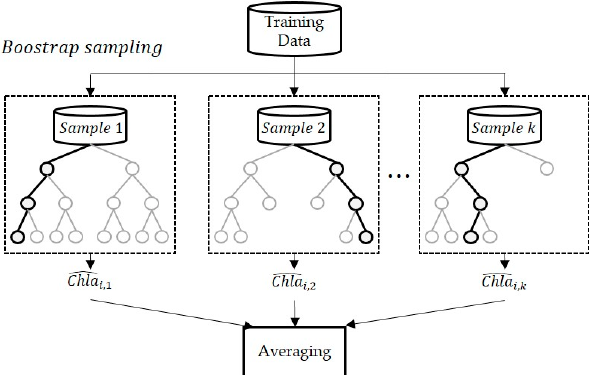
Figure 4. Schematic of the bagging method.